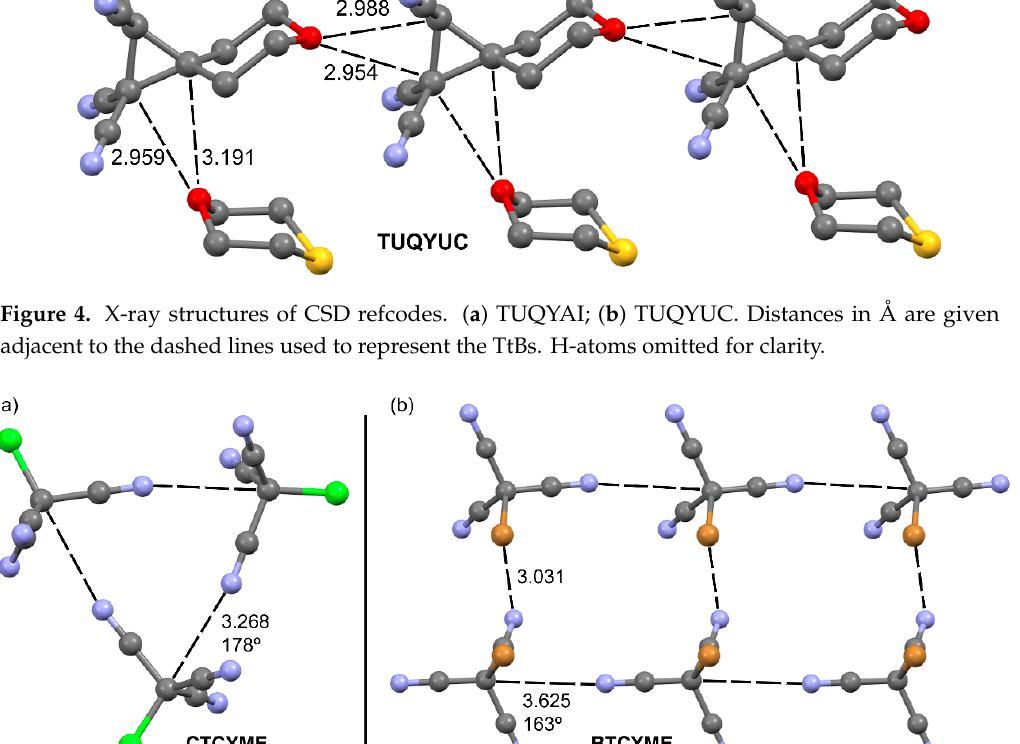
Figure 4. X-ray structures of CSD refcodes. ( a ) TUQYAI; ( b ) TUQYUC. Distances in Å are given adjacent to the dashed lines used to represent the TtBs. H-atoms omitted for clarity.